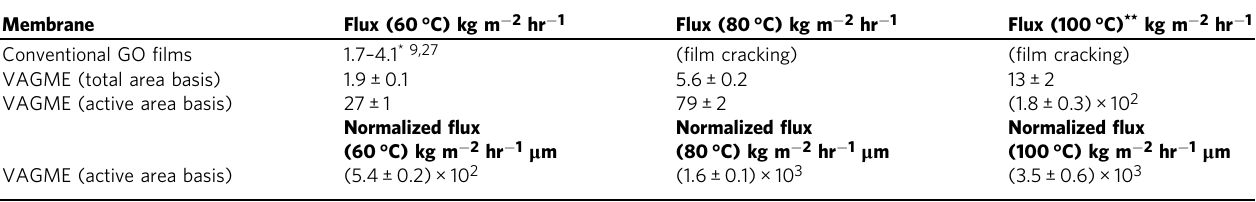
*The fl ux value from ref. 9 includes a calculated temperature correction based on vapor pressure driving force. **The 100°C data is time-dependent and the table entries are average fl uxes over